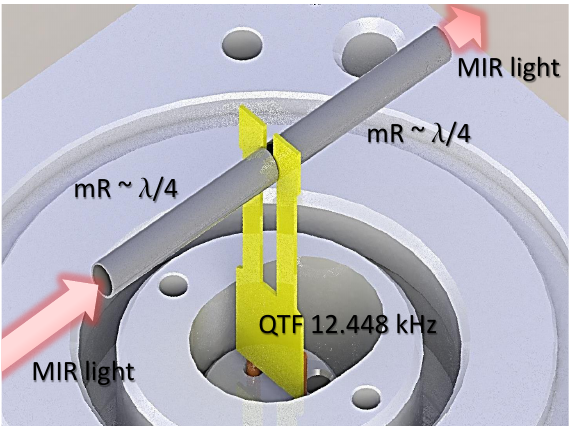
Figure 4. Schematics of the QEPAS cell. The QEPAS cell used for these tests is commercially available (Thorlabs, ADM01). Two micro-resonator (mR) tubes are aligned perpendicular to the QTF plane to probe the acoustic vibration excited in the gas. The length of the mR tubes is 7 mm and the resonant frequency of the QTF is 12.448 kHz. With a gas sample volume of 7 cm 3 . The windows on the cell are made of uncoated BaF 2 with a transmission of